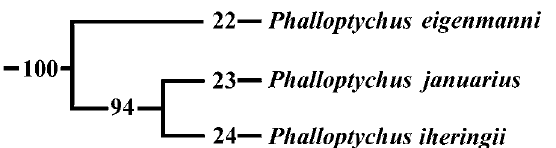
Fig. 2. Intrageneric relationships of Phalloptychus . The num- bers on the branches refer to the character state transforma- tions series listed by Lucinda & Reis